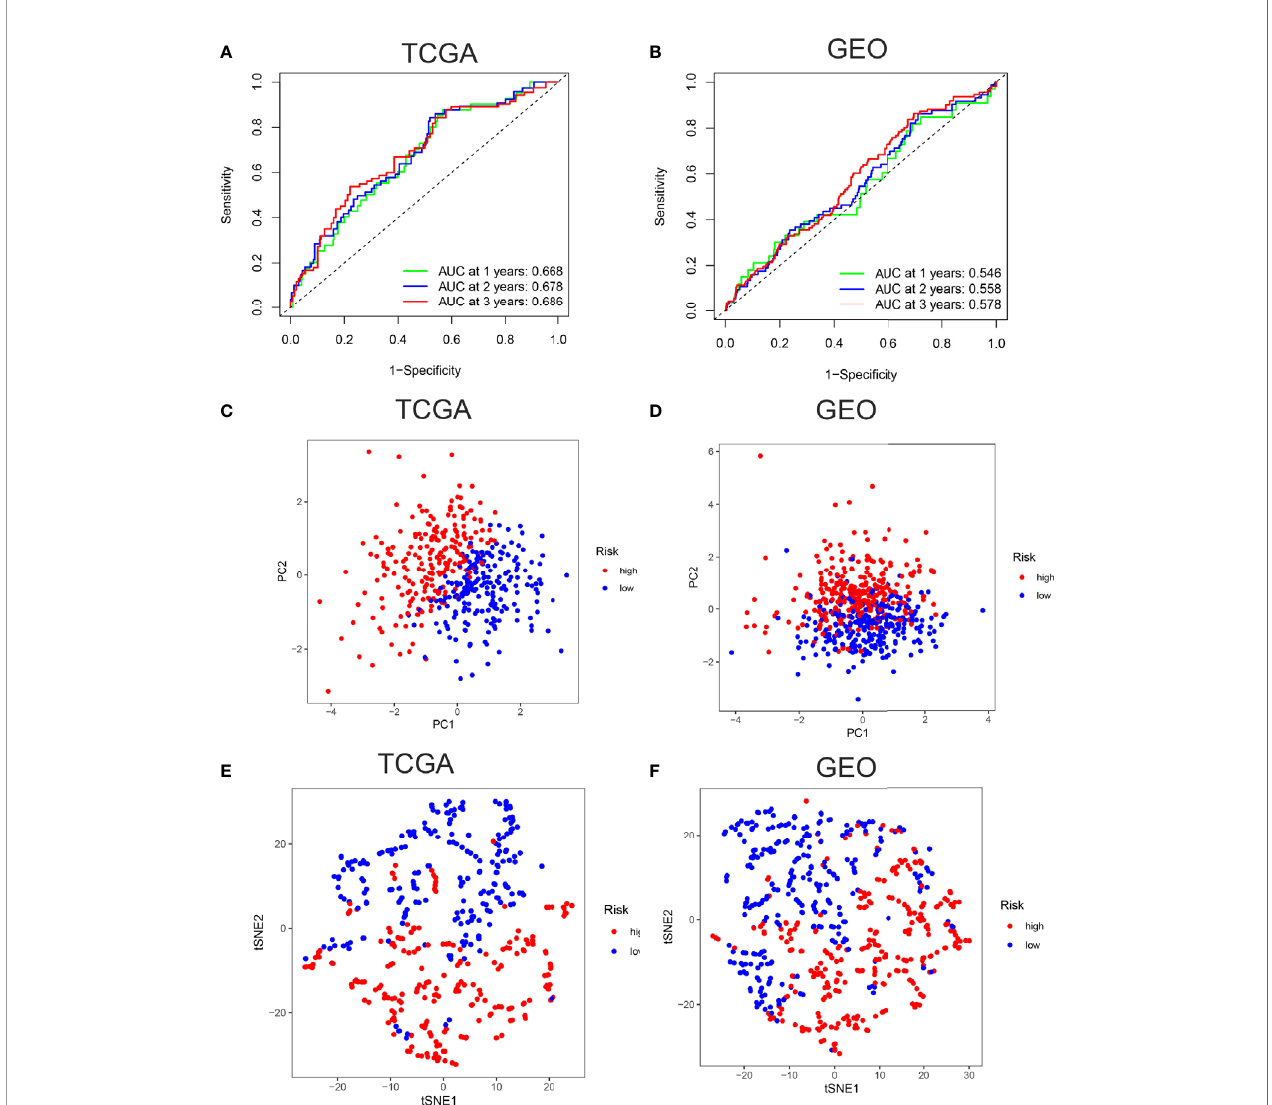
FIGURE 3 | Veri fi cation of accuracy of ferroptosis related gene signature in colon cancer. (A) The AUC score at 1, 2, 3 years in the TCGA cohort. (B) The AUC score at 1, 2, 3 years in the GEO cohort. (C) The PCA plot in the TCGA cohort. (D) The PCA plot in the GEO cohort. (E) The t-SNE plot in the TCGA cohort. (F) The t-SNE plot in the GEO